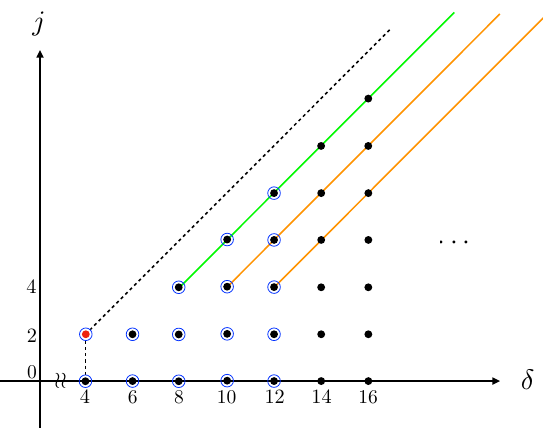
Figure 2 . A plot showing the values of δ, j appearing in the conformal block decomposition (3.5). Black dashed line is the improved unitarity bound from (3.9). The red dot appears only in QCD, and the black dots appear in both QCD and N = 4 SYM. The coefficients h R (1) of dots with a blue circle can be obtained using the direct decomposition method. The h R (1) coefficient of the green line and the h R (0) the Lorentzian inversion